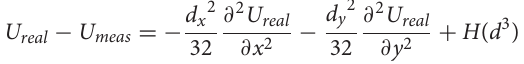
Type 3: Velocity gradient bias resulted from velocity